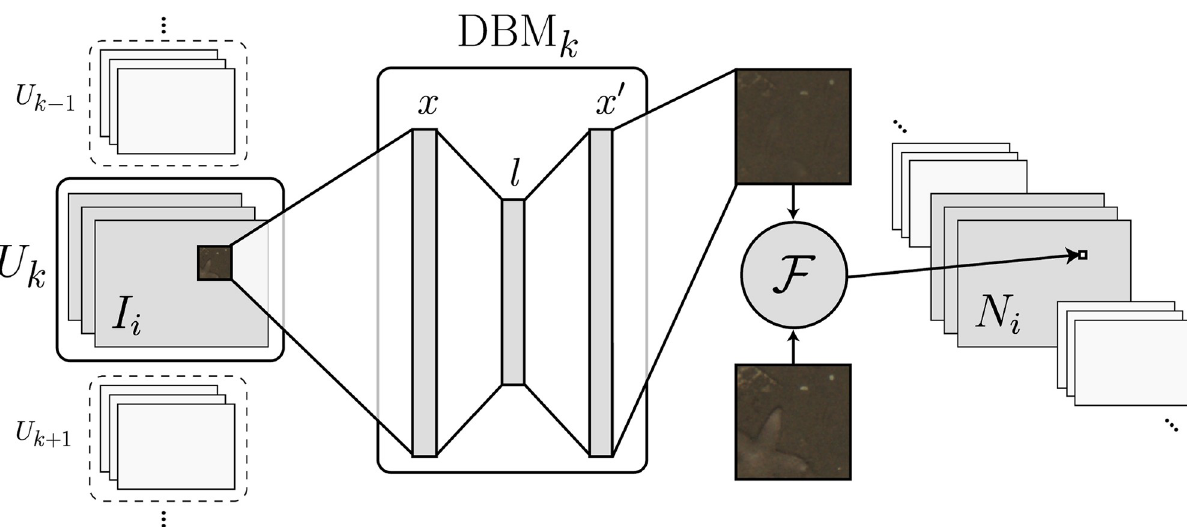
Fig 3. The data-driven background model (DBM ) is applied like a convolution to the input image I k x . The input x is compressed to the latent representation l and then reconstructed to the output x 0 . The reconstruction error F ð x ; x 0 Þ determines the value in the novelty map N at the position of each i